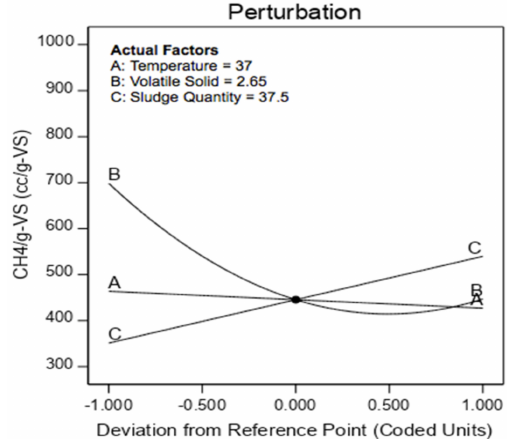
Figure 35. Perturbation plot presents the effect of all factors on CH 4 /g-VS.